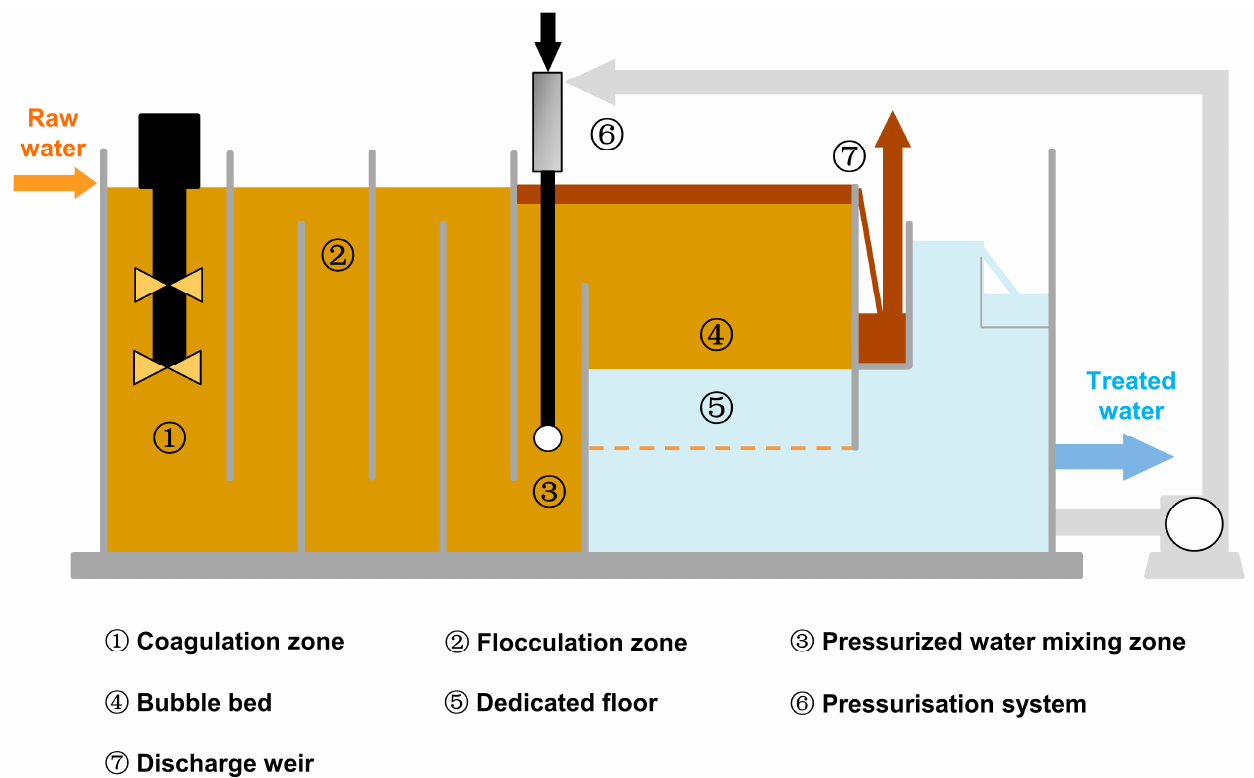
Figure 1. Schematic illustration of the high-speed air flotation equipment.